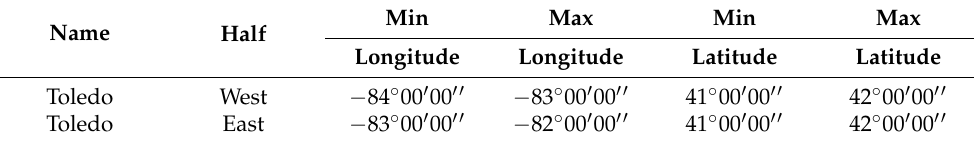
Table 1. List of United States Geological Survey (USGS) DEM 1-degree files used for AERMAP